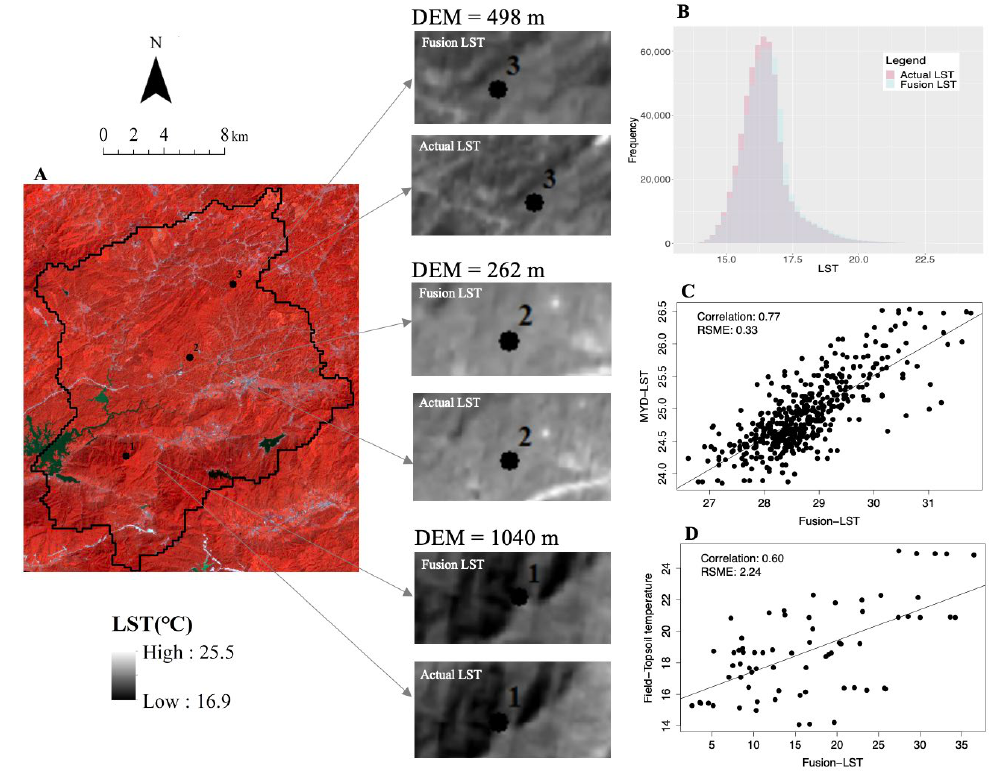
Figure 5. Comparison between the Fusion LST and actual Landsat 8 LST at different altitudes (DEM = 498 m, 262 m, 1040 m) of study area on 28 September 2019 ( A ). The histogram plot of Fusion LST and Landsat 8 LST ( B ). Relationship between the MYD- LST and Fusion LST ( C ) and relationship between the field based topsoil temperature and Fusion LST ( D ).